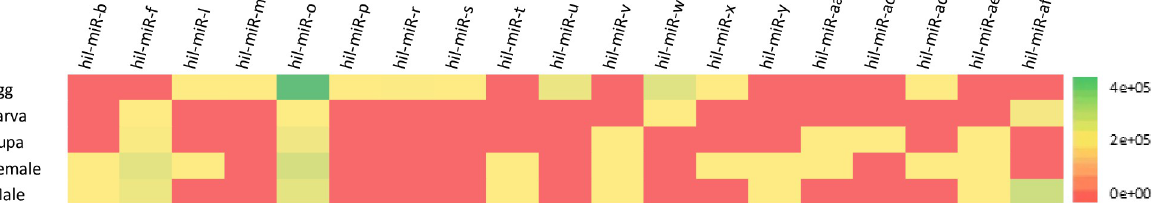
PLOS ONE | https://doi.org/10.1371/journal.pone.0265492 March 17,